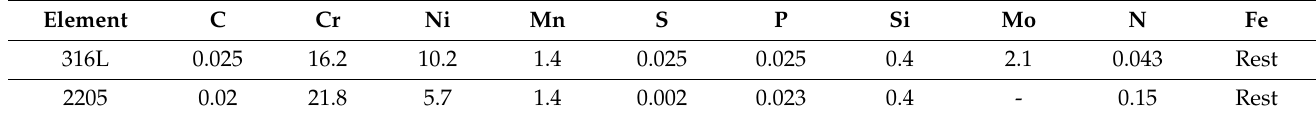
Table 1. Chemical compositions of 316L and 2205 SS (wt.%).